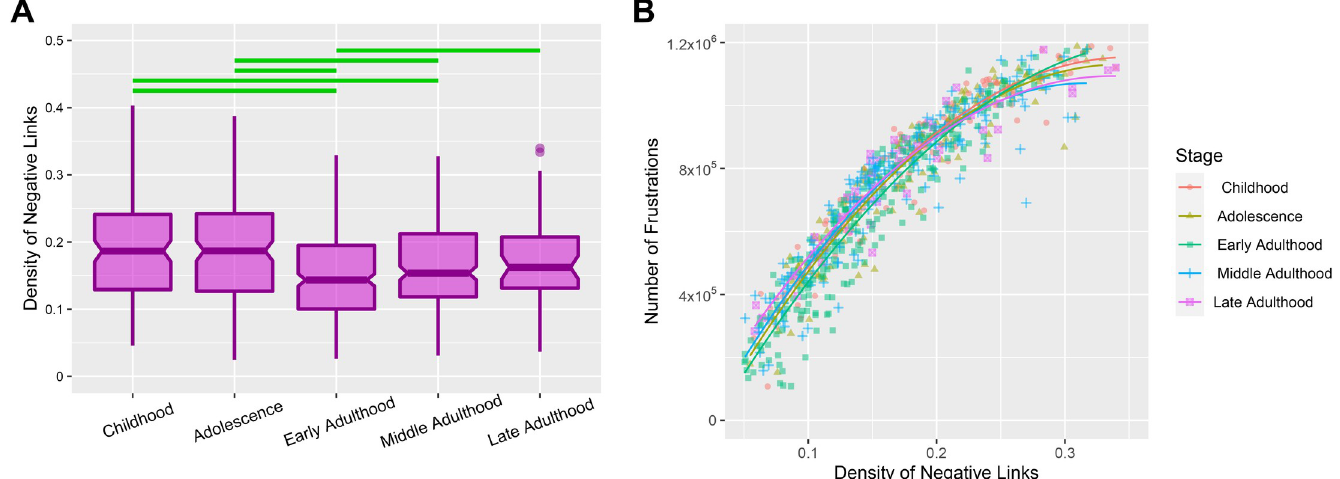
Fig 3. Multiplicity of brain negative connections. (A) Alteration of negative link density of resting-state networks throughout lifespan stages. The notched regions of boxes indicate the median and 95% confidence interval of the medians. Horizontal green lines denote significant differences between stages after correction of multiple comparison effect (corrected p-value � 0.05). (B) A positive non-linear correlation between the density of negative links and the number of frustrations. Each point represents the density of negative links and the number of frustrations corresponding to a subject. The colored shapes indicate developmental stages. The colors of lines also differentiate quadratic functions fitted to the points of each